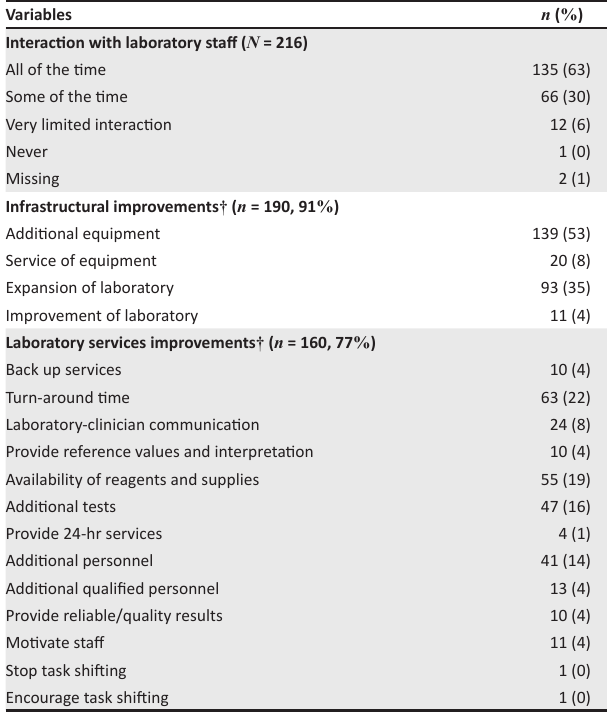
TABLE 6: Laboratory interactions and desired improvements, in Malawi, October-November 2012.